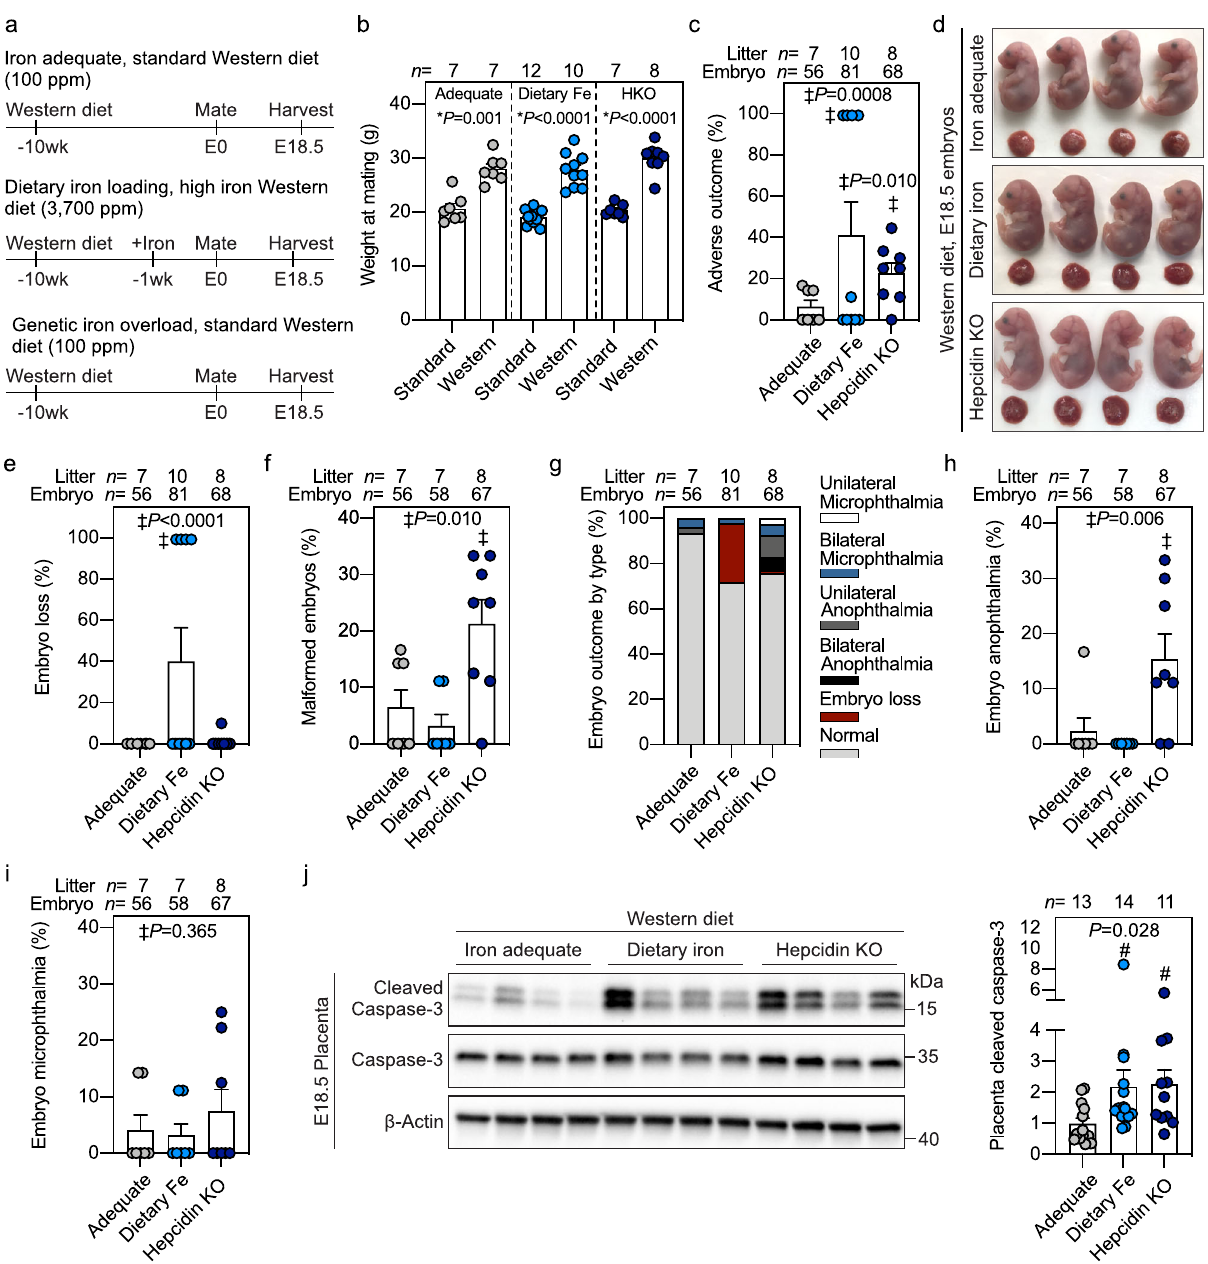
Fig. 6 Iron supplementation potentiates embryonic malformation and placental apoptosis in a mouse model of Western diet-induced obesity. a Starting at 3 weeks of age, wild-type C57BL/6 (iron-adequate) or hepcidin KO (genetic iron overload, dark blue circles) females were fed an iron-adequate Western diet (100 ppm iron) for 8 weeks. After 8 weeks, half of the WT mice were switched to a high-iron Western diet (3700 ppm carbonyl iron, dietary iron loading, light blue circles) for 1 – 3 weeks, while the other mice continued on the iron-adequate Western diet (gray circles). Mice were mated and continued their respective diets during pregnancy. Iron adequate dams were compared to dietary or genetic iron-loaded dams. b Weight of female mice at mating fed a Western diet compared to those fed non-obesogenic diet. c Incidence of E18.5 embryos with adverse outcomes in obese pregnancies. d Embryo gross morphology and e incidence of embryos with subcutaneous hemorrhaging or f malformations. g Incidence of embryo malformations categorized by type. Incidence of embryo h anophthalmia and i microphthalmia. j Western blot (left) and quantitation (right) of cleaved caspase-3 in whole placentas normalized to β -actin. Representative blot of n = 11 – 14 randomly selected placentas/group. b , c , e , f , h – j Error bars represent mean ± s.e.m. Statistical differences were determined by two-tailed Student ’ s t -test (denoted by *), one-way ANOVA on ranks followed by Dunn ’ s method for multiple comparisons (denoted by #), or Fisher ’ s exact test (indicated by ‡ ). P -values are indicated in each fi gure panel. Source data are provided as a Source data fi Examination of embryos for gross malformations demon- malformations in only ~6% of embryos (Fig. 6c – i). Dietary iron strated higher incidence of adverse embryo outcomes when both loading of obese dams caused complications in 41% of maternal iron excess and obesity were present. Obesity in iron- pregnancies (Fig. 6c), including embryo loss characterized by adequate dams caused embryo complications including eye resorption or fatal subcutaneous hemorrhaging ( P < 0.001)